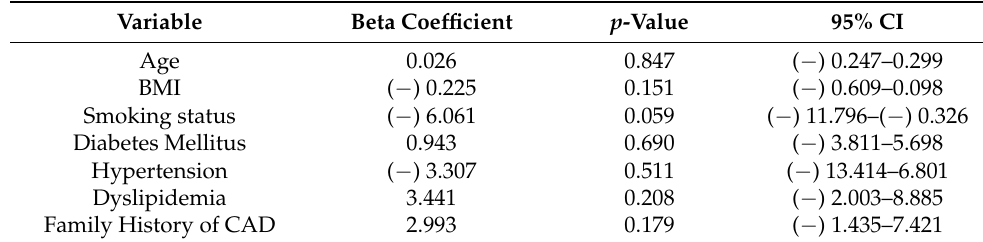
Figure 2. Percentage of war-related stressors within each SX score category. Chi-square testing shows a significant associ- ation between only crossing green-lines and SX score categories. Crossing green-lines ( p < 0.01), living in a dangerous area ( p = 0.11), and neighborhood dissatisfaction ( p = 0.96).